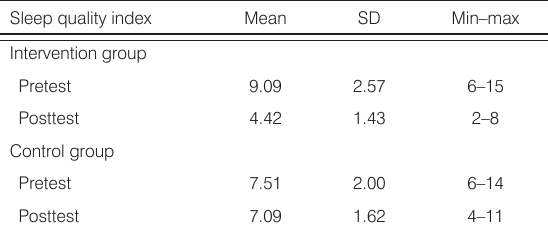
Table 1. Pretest and posttest sleep quality indexes in the intervention and control groups ( n